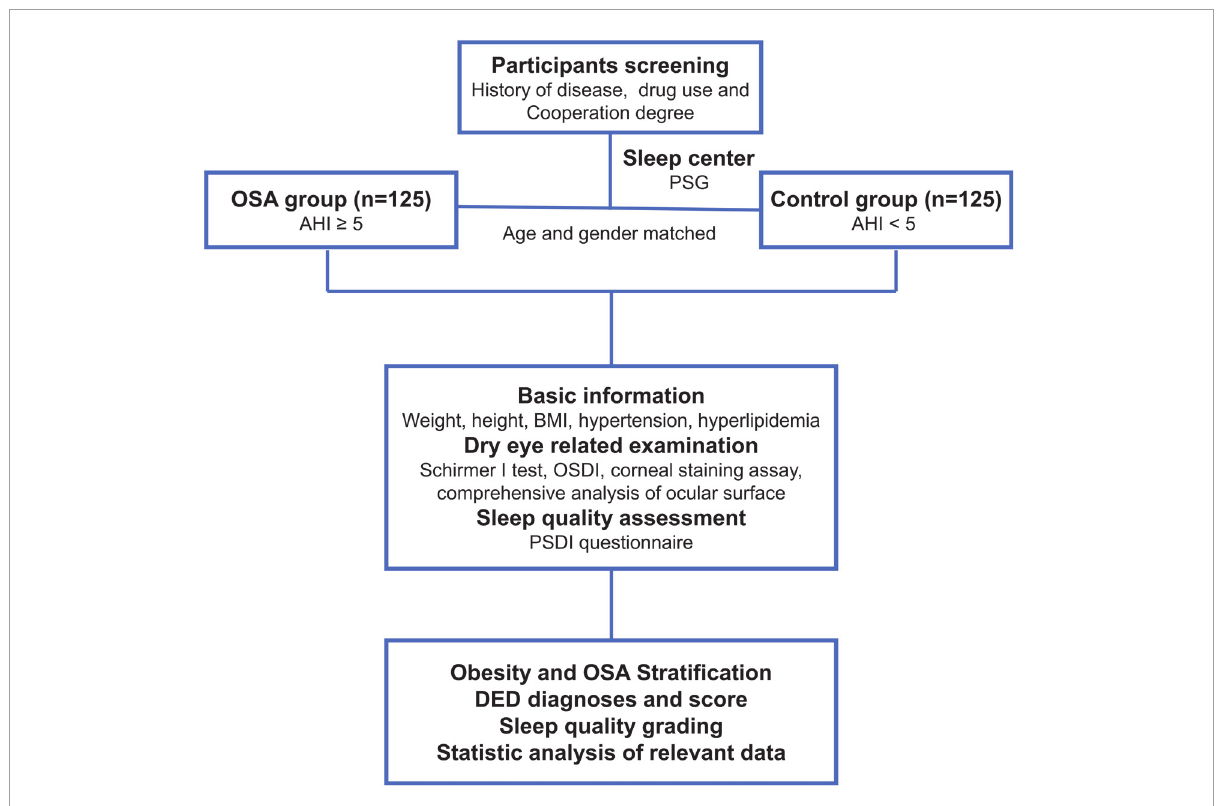
FIGURE1 Detailed flow diagram of study design and participants